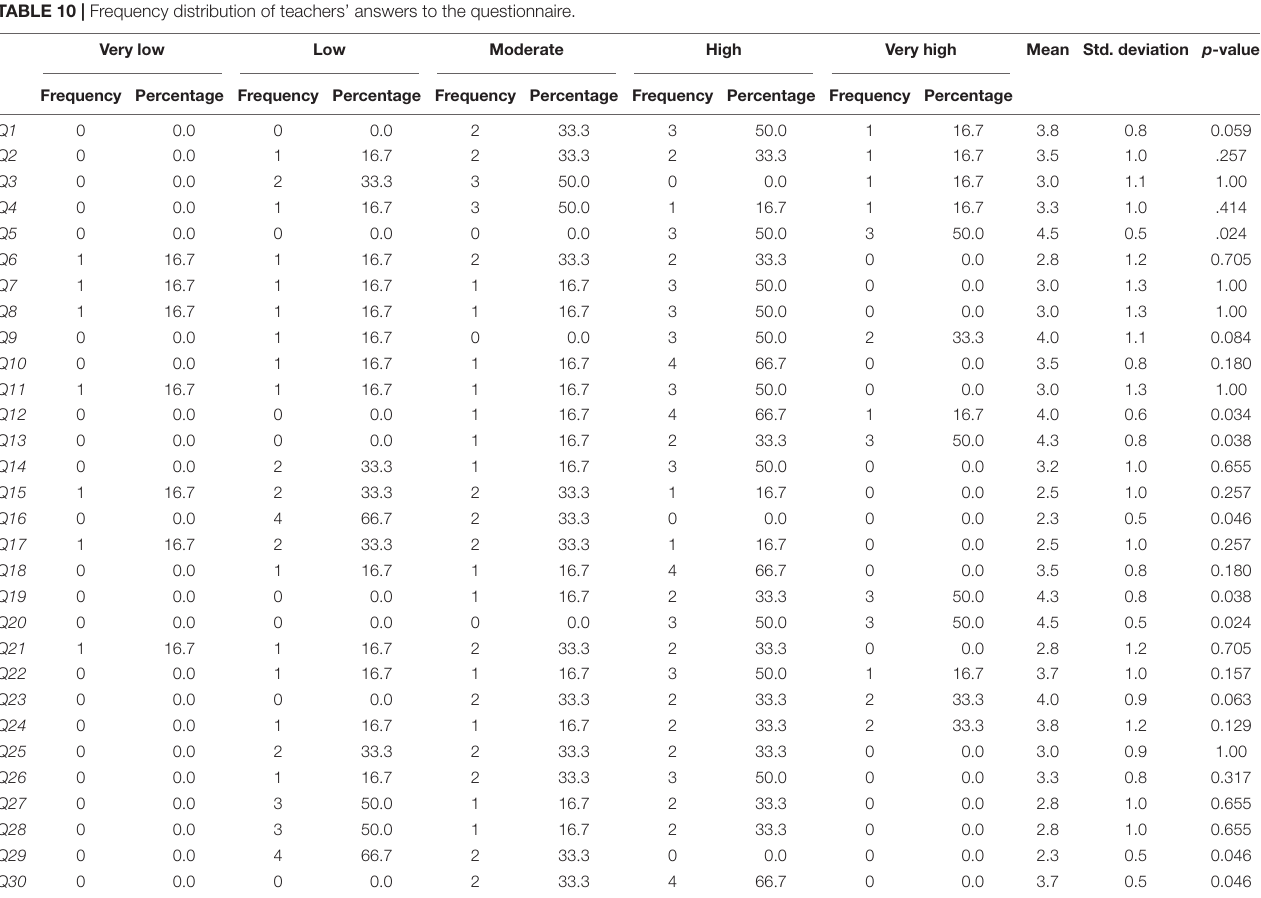
TABLE 9 | Independent T-test results in comparison of difference between pre-test and post-test scores of the control group and the experimental group. Variable Group N Mean Std. deviation T Df p -value Reading ability (post-test-pre-test)